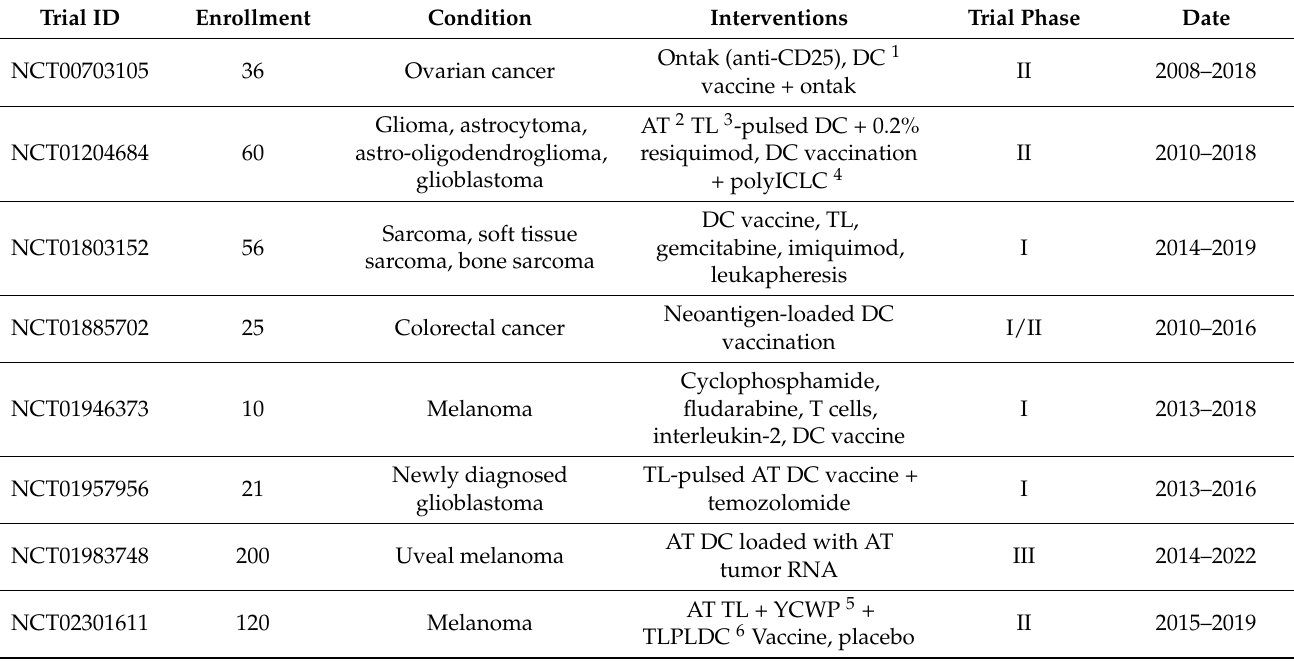
Table 1. Selected clinical trials of dendritic cell-based cancer